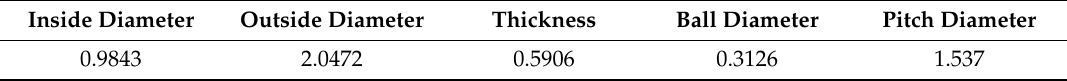
Table 2. Drive end bearing size (inch).